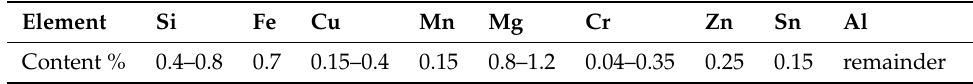
Table 1. Chemical composition of workpiece (Al 6061) [32].